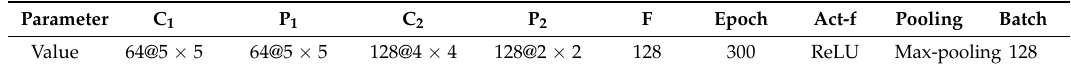
Table 2. Optimal parameters in the PO-2DCNN